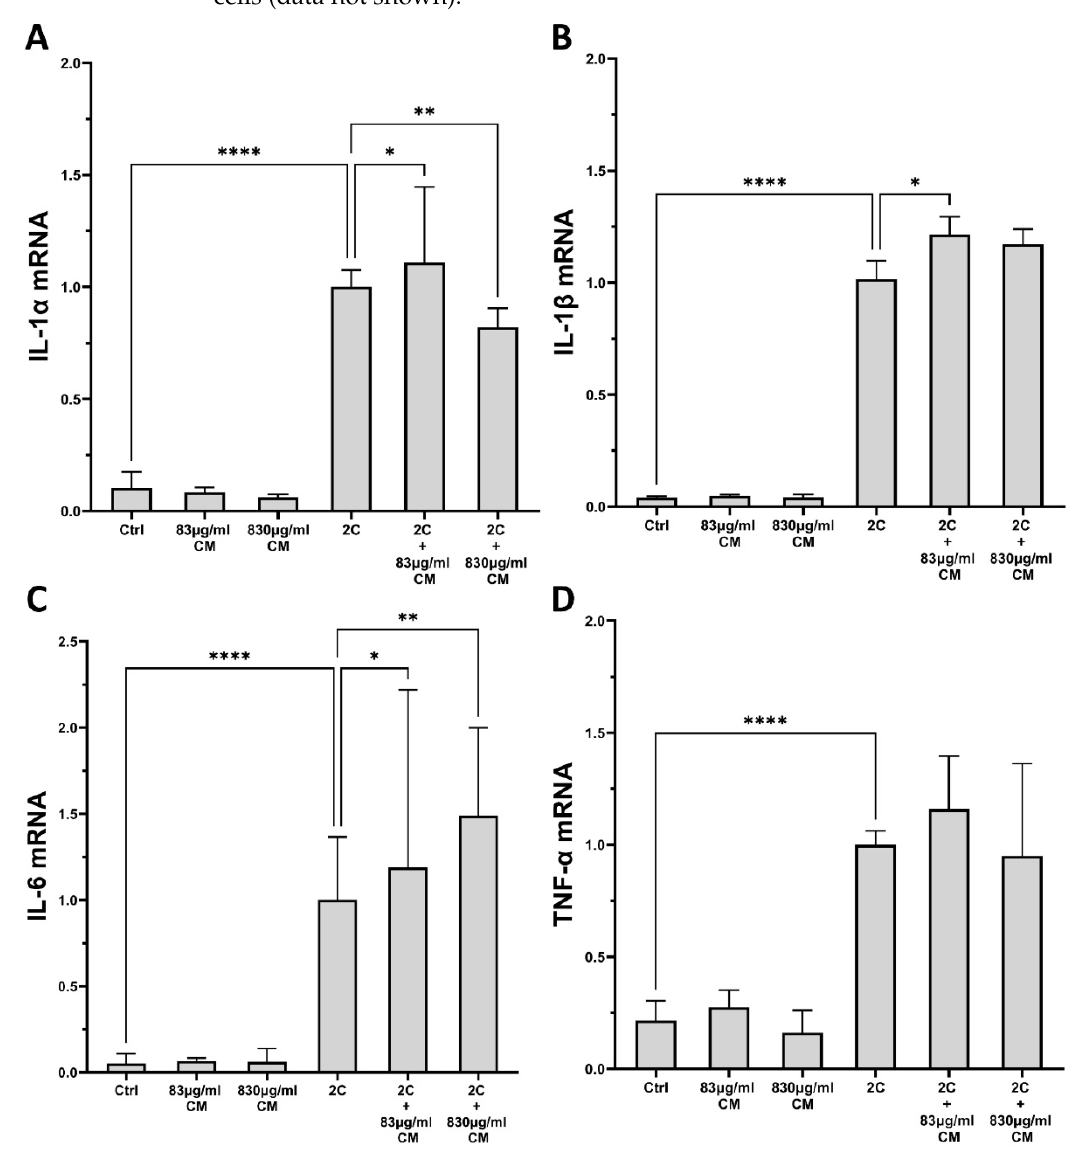
Figure 5. The effect of CM on interleukin mRNA expression in A549 epithelial cells, which are under pro-inflammatory stimuli. A higher CM dose downregulates the mRNA expression of IL-1 α ( A ), and a lower CM dose upregulates the mRNA expression of IL-1 β ( B ), either CM dose increases the mRNA expression of IL-6 in a dose-dependent way ( C ) and has no effect on the mRNA expression levels of TNF- α ( D ). 2C: IL-1 α 5 ng/mL + TNF- α 50 ng/mL; 830 μ g/mL total protein of CM; 83 μ g/mL total protein of CM. Results are presented as median with interquartile range. **** p < 0.0001; ** p < 0.01; * p < 0.05. N = 3.